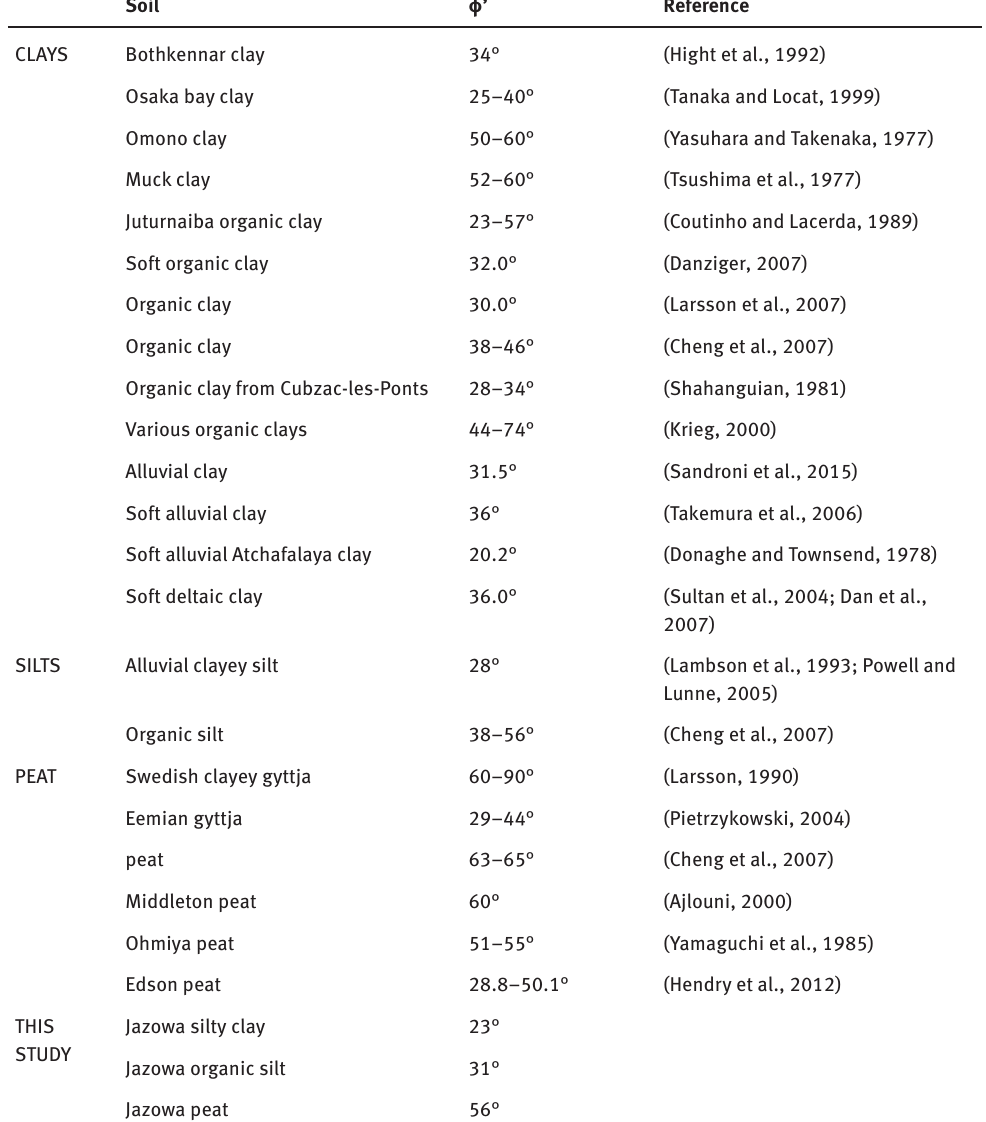
Table 3: Effective friction angle of soft soils